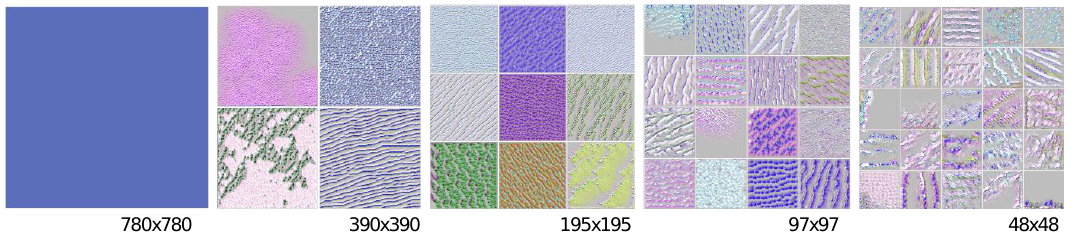
Figure 3. Filters with indicated image size in pixels. Filter size decreases from left to right whereas the number of filters increases from 32, 64, 128, 256 to 512. For clearness, only a few exemplary filters are